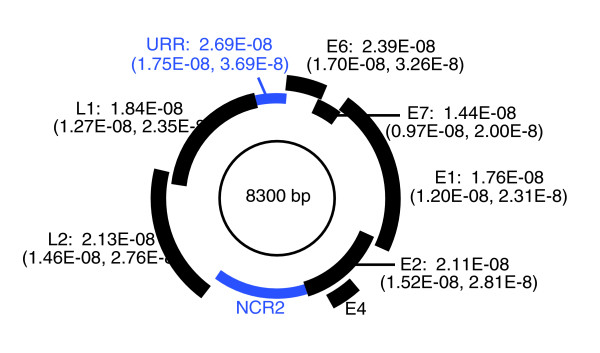
Feline papillomavirus evolutionary rates. Schematic representation of the circular feline papillomavirus (PV) genome with mean evolutionary rates (in nucleotide substitutions per site per year) and confidence intervals for the separate coding genes and the upstream regulatory region (URR). The URR and the second noncoding region (NCR2), which is unique for the PVs of the genus λ-PV, are shown in blue.